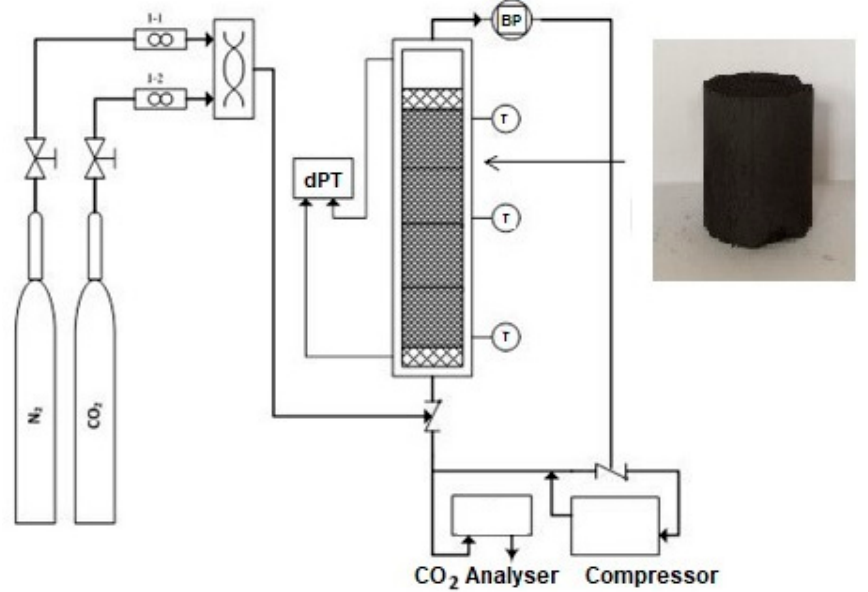
Figure 1. A graphical illustration of the experimental set-up for adsorption of carbon dioxide (CO 2